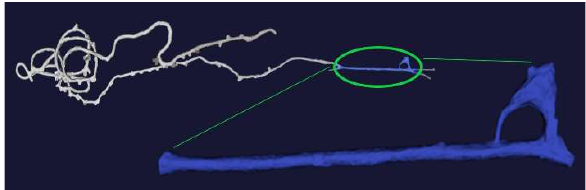
Figure 9. Space decomposition of one branch of the